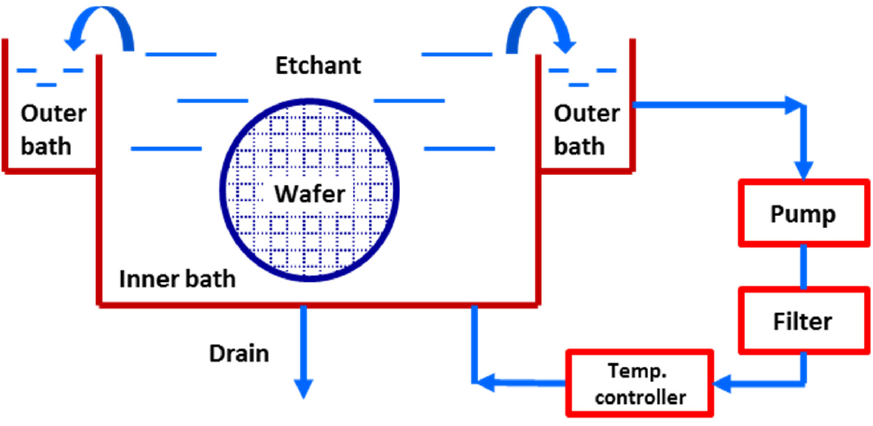
Figure 1. The schematic diagram of the wet etching bath.